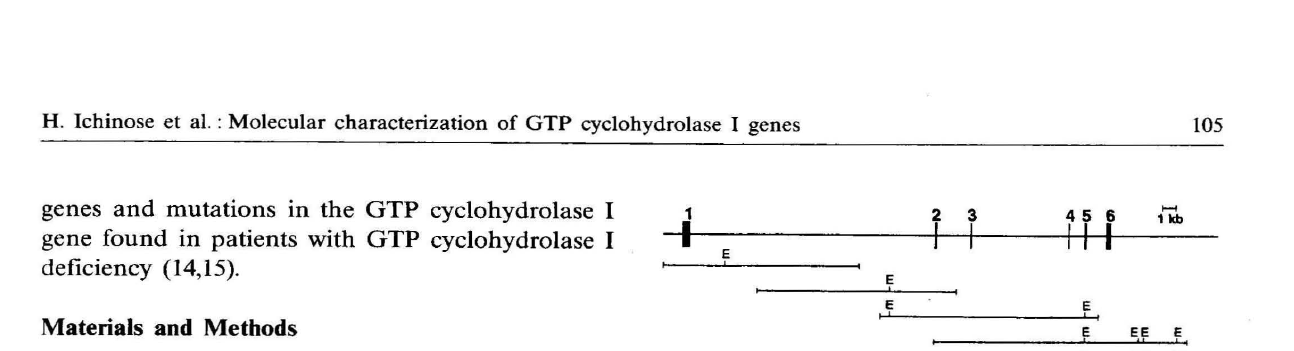
Fig. 1. Structure of the mouse GTP cyclohydrolase I gene. The structure of the mouse GTP cyclohydrolase I gene is depicted at the top of the figure. The 6 exons are indica ted by closed boxes, and introns are represented by thin horizontal lines. Five isolated clones covering more than 30 kb of the mouse GTP cyclohydrolase I gene are depicted below the structure of the gene. EcoRI restriction sites (E) are indicated by vertical